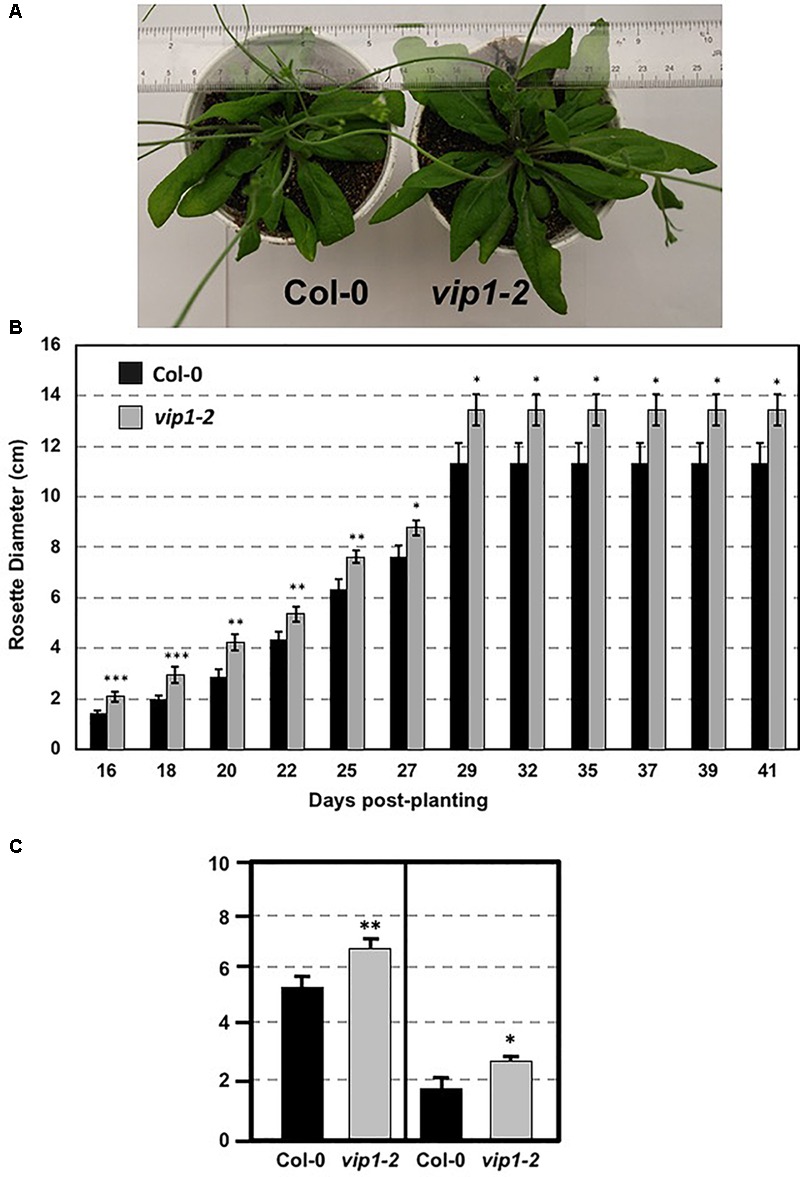
Growth of wild-type and vip1-2 mutant Arabidopsis plants. (A) Mature (29-day-old) wild-type (Col-0, left) and vip1-2 mutant (right) plants. (B) Bars represent the average diameter, ± SE, of leaf rosettes on 5–7 plants grown for the indicated number of days. (C) Bars represent the average leaf length (left) and width (right), ± SE, of the three largest leaves on five plants of each genotype grown for 29 days. Student’s t-test ∗P-value < 0.1, ∗∗P-value < 0.05, ∗∗∗P-value < 0.01.